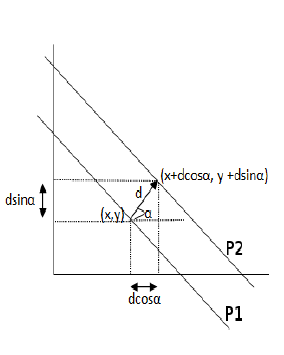
Figure 5: Geometric interpretation of Vector decomposition based detail